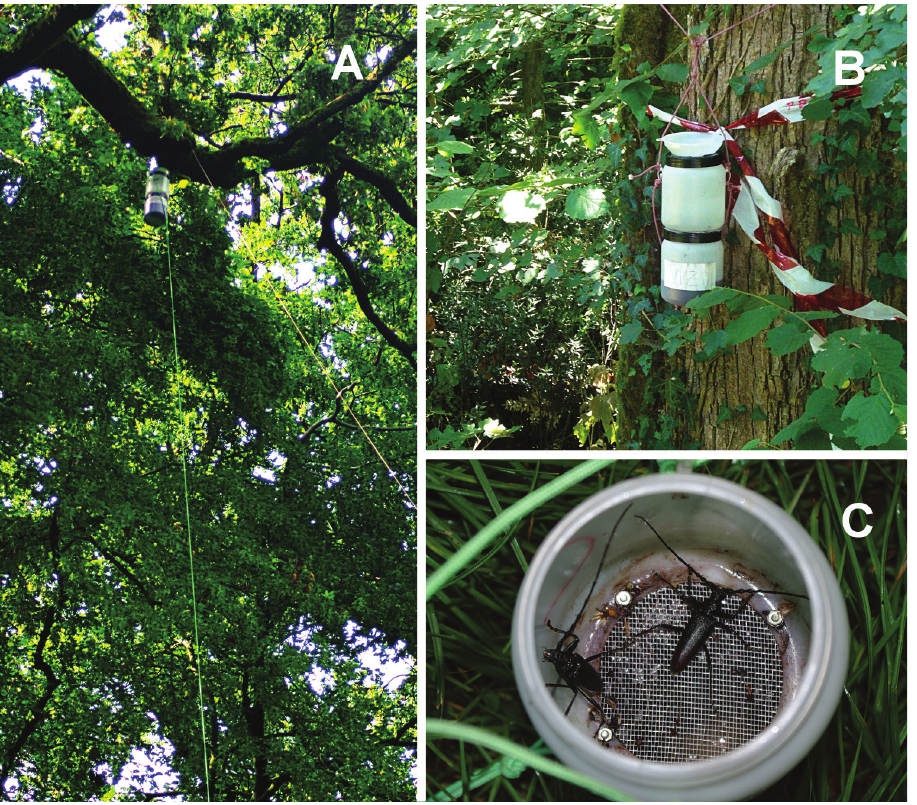
Figure 4. Baited traps set at two heights: A on a branch over 10 m high B on trunk, 1.5–2 m above understory level and C an example of capture of two individuals of Cerambyx cerdo . In picture A the ropes to lower and lift up the trap are visible, green and brownish respectively (Photo by M.